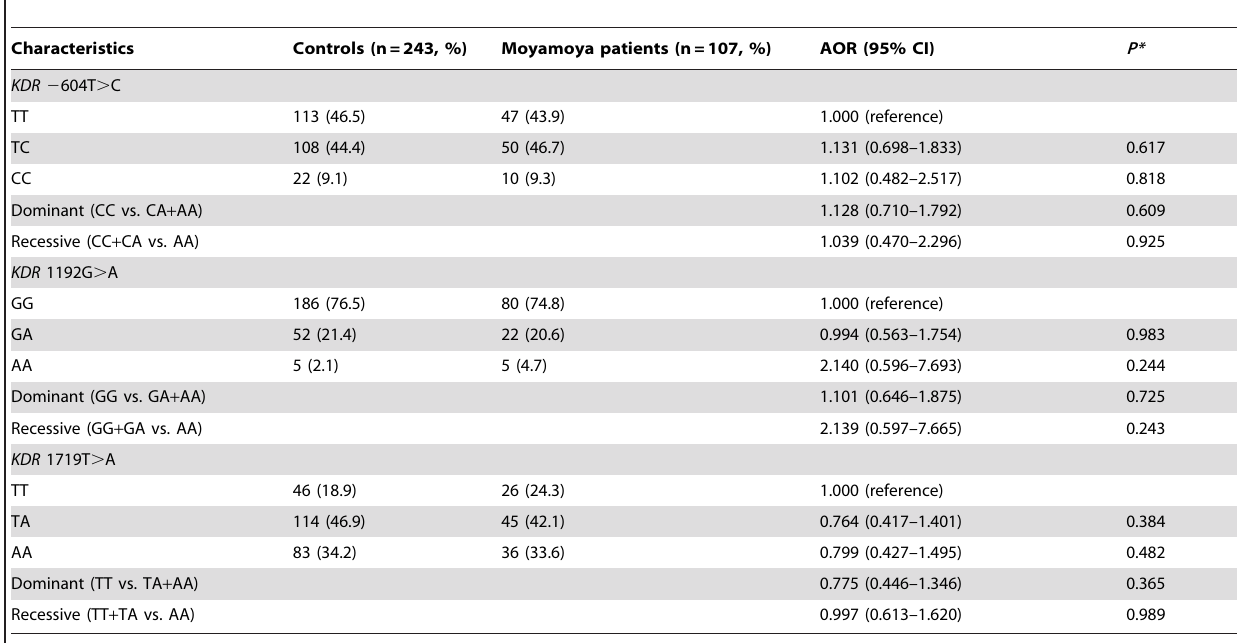
Table 3. The frequencies of the KDR 2 604T . C, 1192G . A, and 1719T . A polymorphisms between control subjects and patients with moyamoya